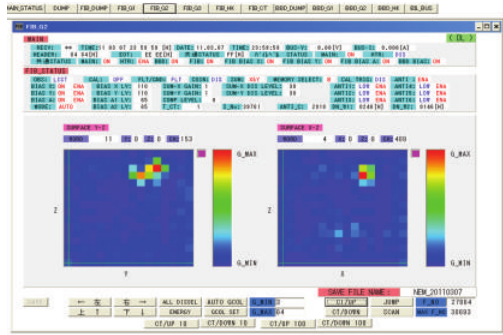
Figure 10: Solar neutron the event number 39,761 detected by the FIB sensor at 20:10 :26 UT on March 11, 2011. The solar direction was located toward the lower left side in y - z plane (the left side panel), while in the right side panel the solar direction was down ward almost vertically. The energy of the track is estimated as (44 ± 5) MeV and the neutron may be emitted around 19:50:38 UT at the Sun, if the track was induced by the n-p collision. Solar neutrons on March 7, 2011 with M3.7